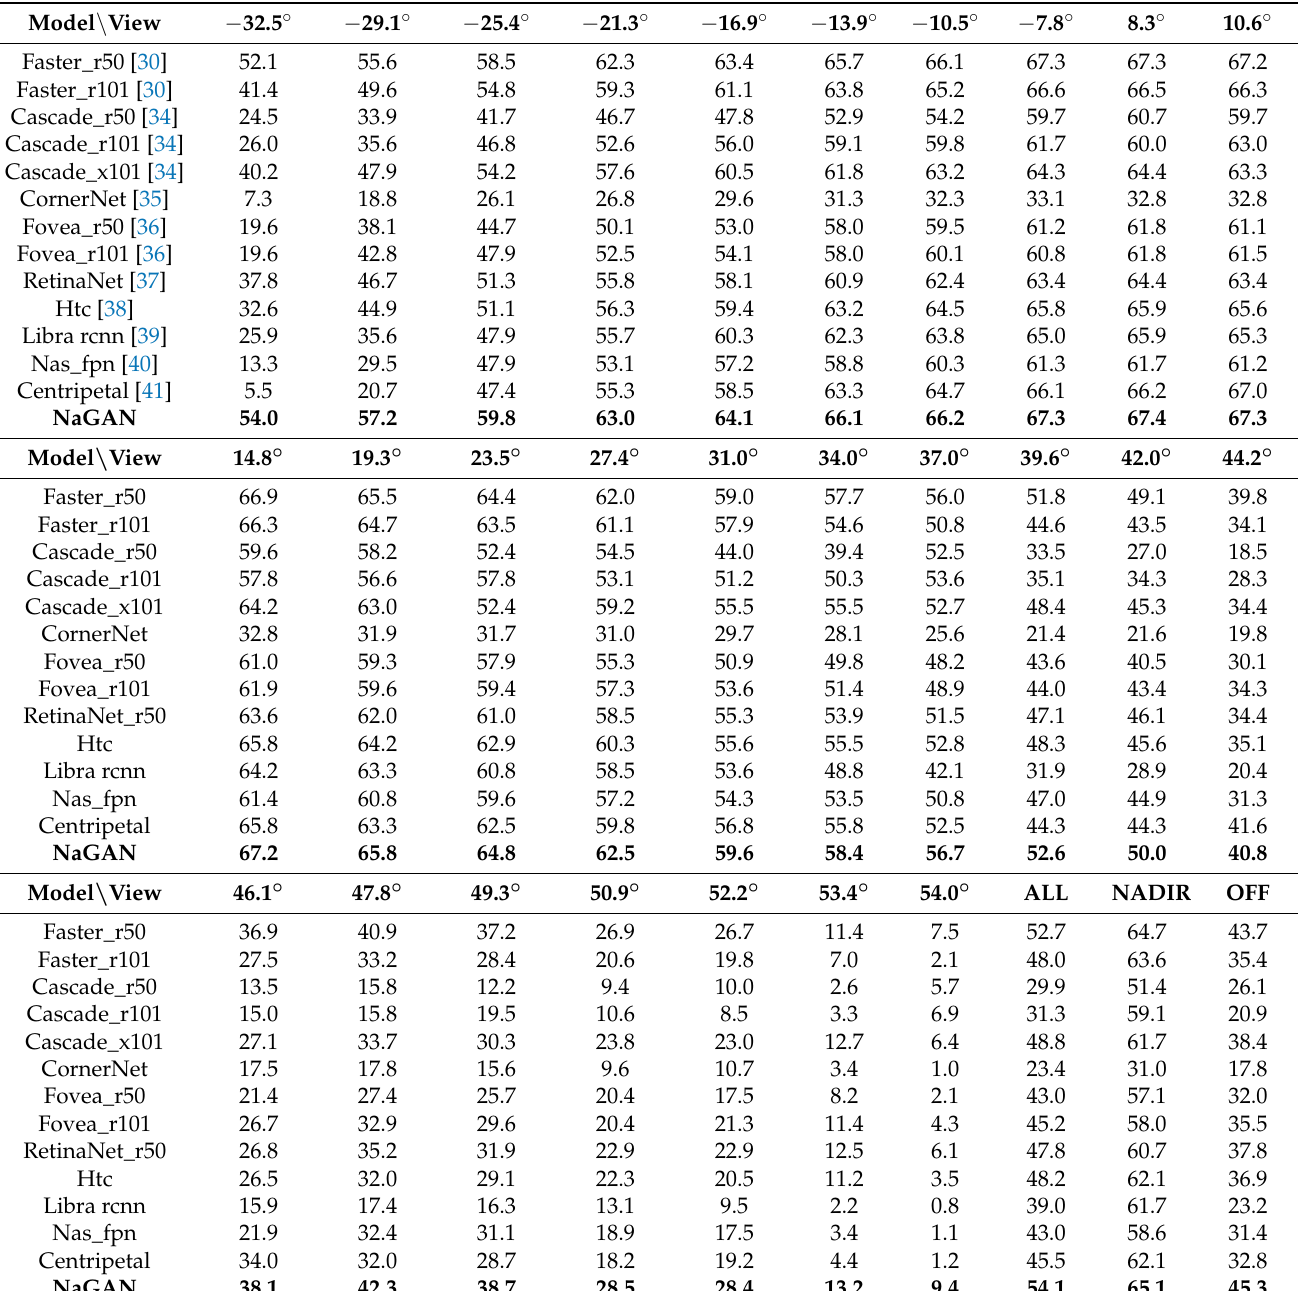
Table 1. Performance comparison for each view on SpaceNet in terms of AP@0.5 in